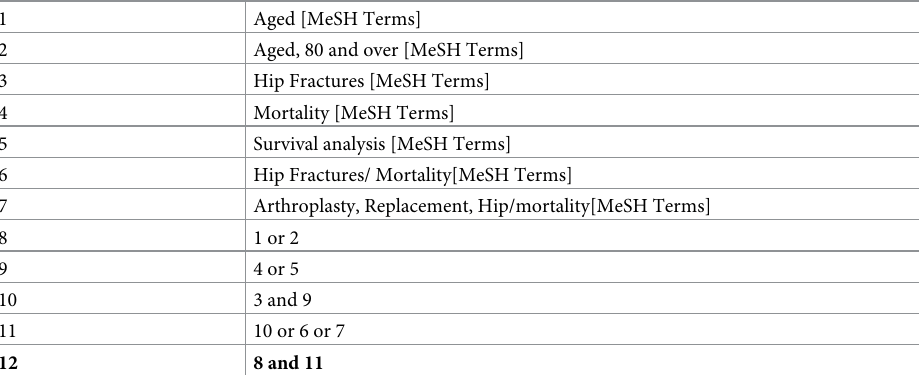
Table 1. Search strategy